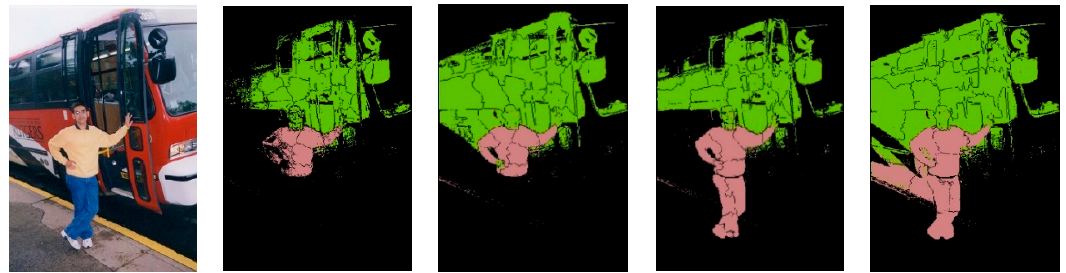
Figure 7. Semantic segmentation graph of different iteration times. The number of iterations is epoch #1, epoch #4, epoch #8, and epoch #10.